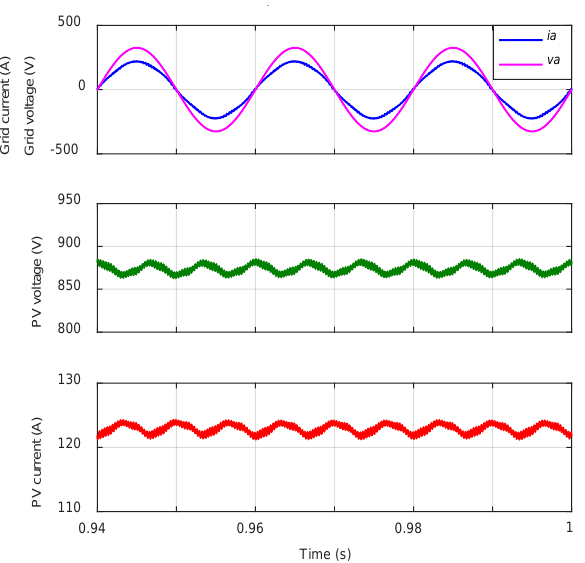
Figure 9. Input/output steady-state waveforms of the FC in case of sun irradiance E = 1000 W/m 2 : grid voltage and current (top traces), PV voltage (middle trace) and PV current (bottom trace).